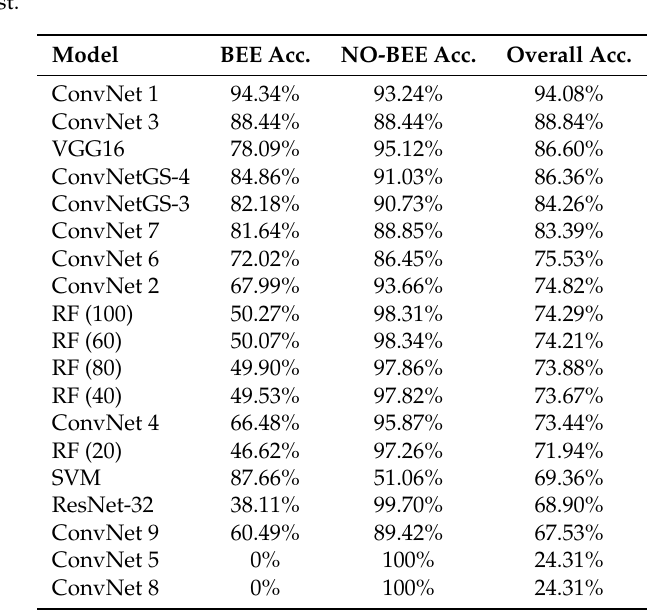
Table 6. Model performance on BEE2_1S validation dataset; all hand-designed ConvNets, ResNet32, and VGG16 were trained for 100 epochs each. The two top performing auto-designed ConvNets (ConvNetGS-4 and ConvNetGS-3) are included for comparison. The overall accuracy is sorted from highest to lowest.